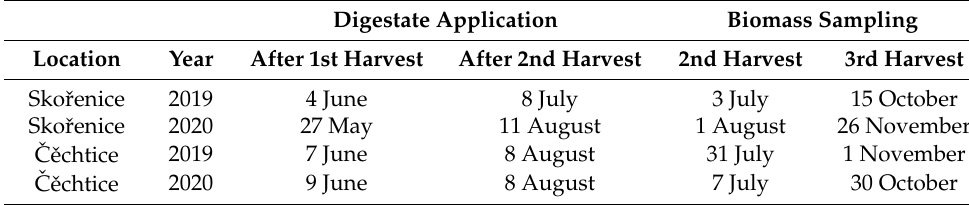
Values are expressed as a mean ± standard deviation. Table 3. Dates of digestate application and biomass harvest each year.